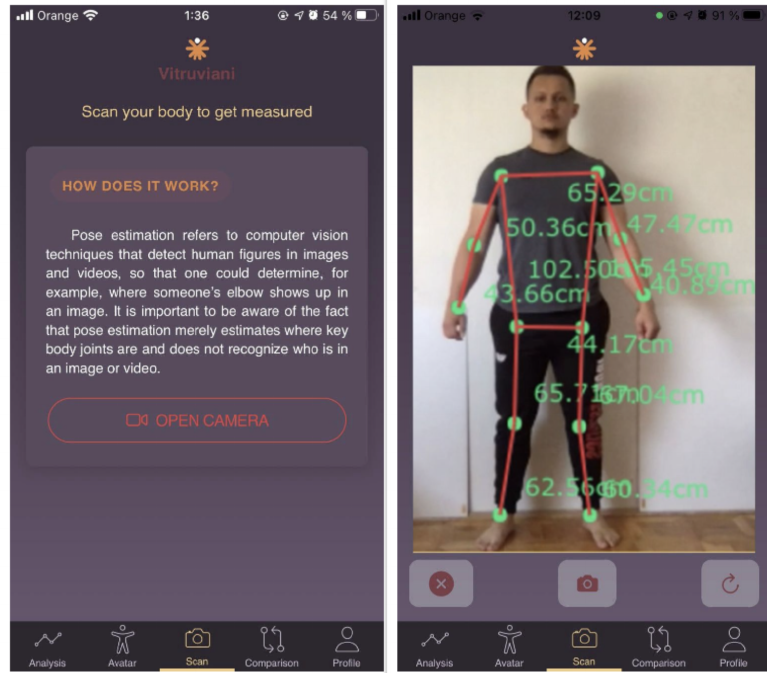
Figure 8. Measurement capture page vs. visualization page of keypoints.